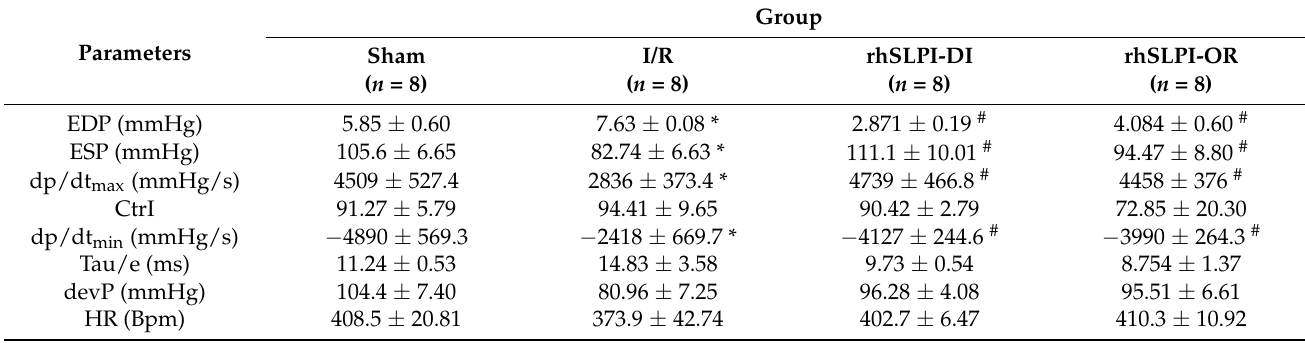
Table 3. The parameters of left ventricular pressure of reperfusion phase determined the rhSLPI effect on LVP parameters in MI (120 min after